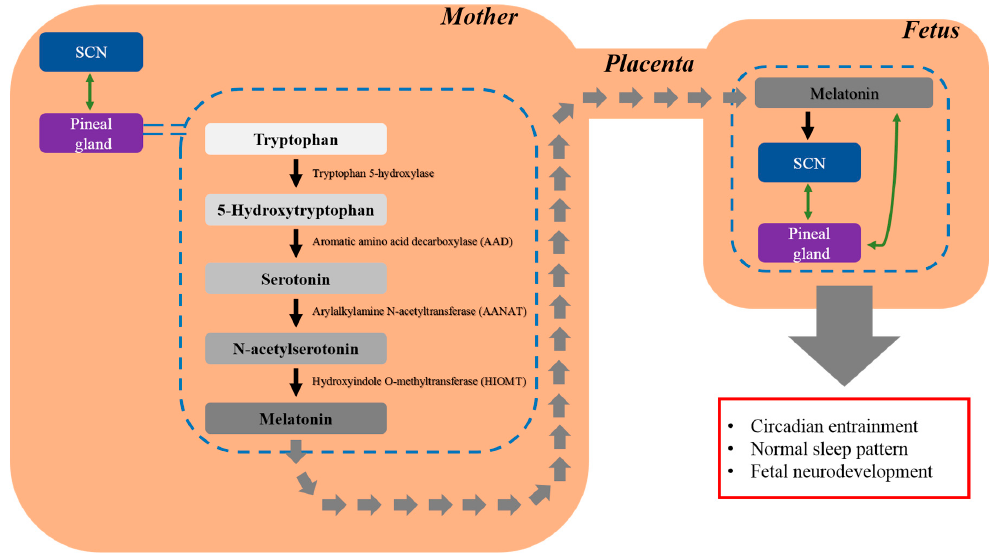
Figure 1. Maternal melatonin crosses the placental barrier to entrain the fetal circadian rhythm. Thus, melatonin is present in the fetal brain prior to the maturation of the fetal pineal gland. After crossing the placenta, melatonin entrains the fetal circadian rhythm, maintains the normal sleep pattern, and protects the fetus from neurodevelopmental disorders such as ASD.